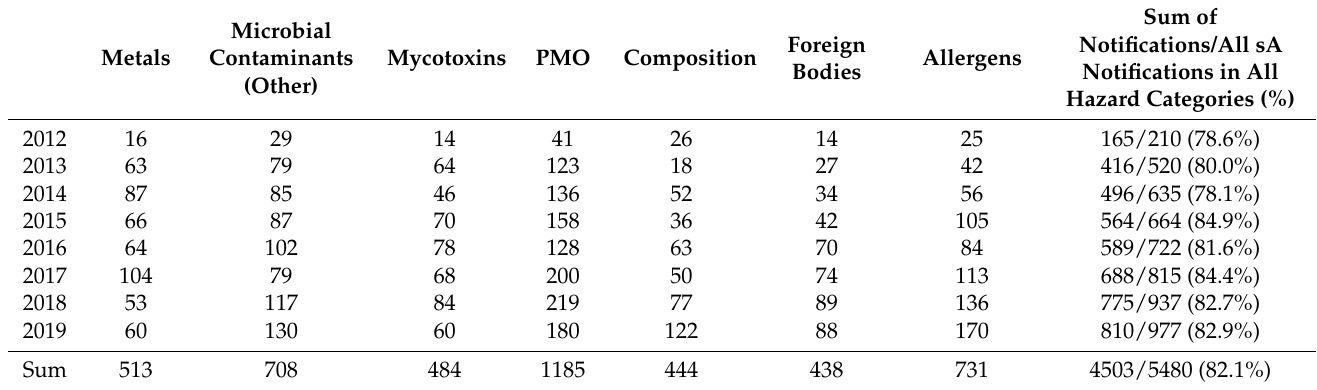
Table 1. Yearly distribution of serious alert (sA) notifications, in seven hazard categories (mycotoxins, microbial contami- nants (other), foreign bodies, composition, allergens, metals, pathogenic microorganisms (PMO)) and their sum as a percent share (%) of all sA in all hazard categories in the EU RASFF database (2012–2019).